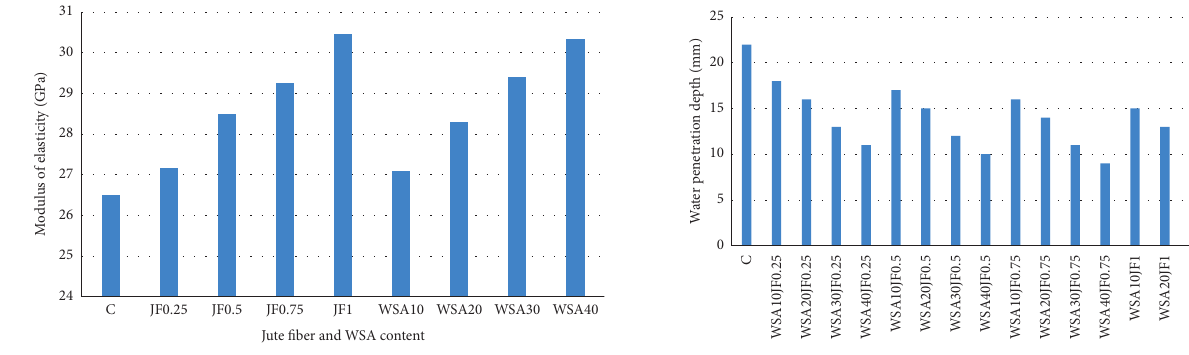
Figure 10: Modulus of elasticity of mixture containing jute fiber and WSA.